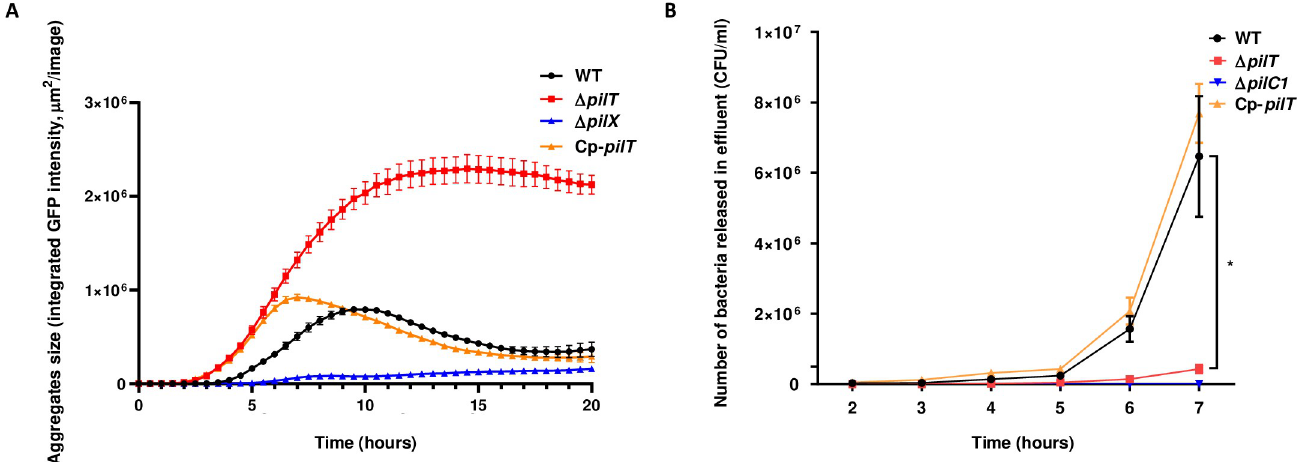
Fig 6. PilT-dependent pilus retraction is critical for bacterial release from microcolonies adherent to endothelial cells. (A ) Aggregates of WT N . meningitidis , its isogenic Δ pilT mutant, Cp- pilT complemented strain and Δ pilX mutant producing GFP under an IPTG-inducible promoter and grown in liquid medium were imaged using the IncuCyte S3 platform at 37˚C with 5% CO 2 . Four image sets from distinct regions per well were taken every 15 min using a × 20 dry objective and each condition was run in triplicate. Bacterial aggregates formation and dispersion was measured over a period of 20 h under static condition. (B) Number of bacteria detaching from microcolonies adhering onto human dermal microvascular cells (HDMEC) under flow condition. Cells were infected for 30 min under static condition with WT N . meningitidis , Δ pilT mutant, Cp- pilT complemented strain, and Δ pilC1 mutant as non-adhesive control. Cells were then washed to remove non-adherent bacteria and placed under shear stress of 0.15 dyn/cm 2 . Bacterial count in the effluent was evaluated each hour by plating serial dilutions on agar plates. Three independent experiments. Bars represent mean ± SEM. � p < 0.05, one-way ANOVA followed by multiple comparison test.